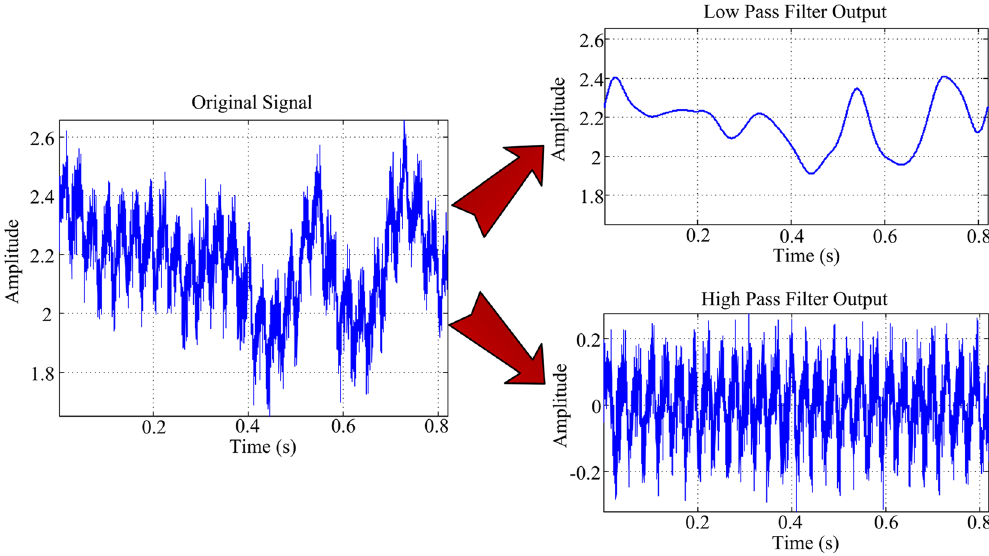
Figure 3. The separation of the body-movement and wing-beating signal